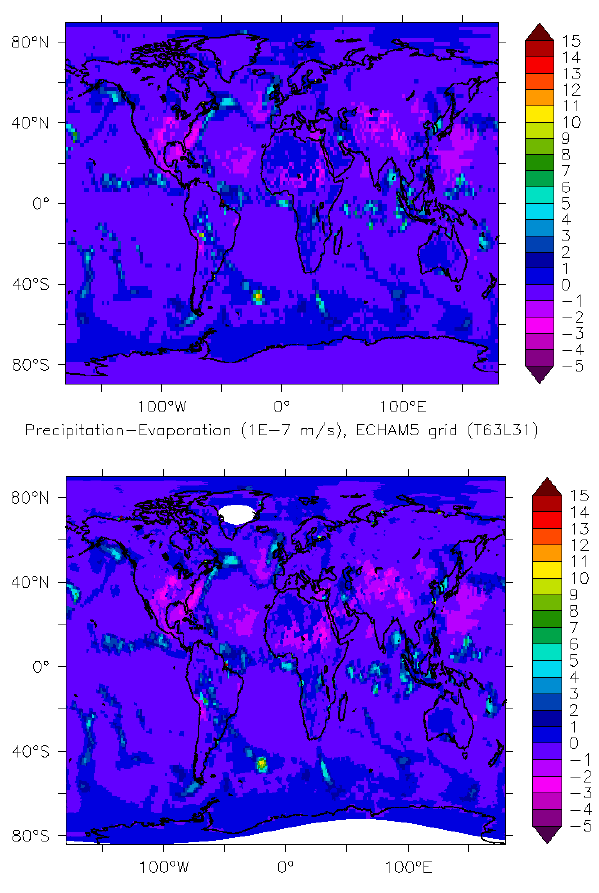
Fig. 3. Example of a grid transformation with the SCRIP library routines embedded in the generic MESSy submodel MAIN GRIDTRAFO and called by A2O: the precipitation minus evaporation field on the EMAC grid (top) has been transformed to the MPIOM grid (bottom) using the conservative remapping.